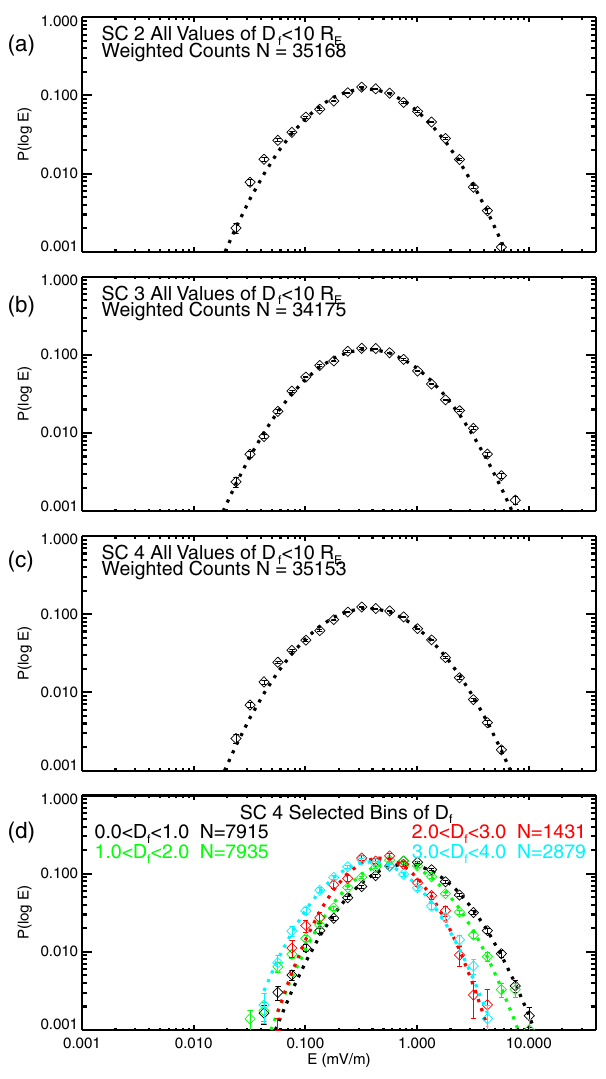
Fig. 4. Probability distributions for the electric field waveform am- plitudes observed by the Cluster WBD Plasma Wave Receiver on 26 March 2002. The probability distributions for all values of D f using weighted counts for (a) spacecraft 2, (b) spacecraft 3, and (c) spacecraft 4. The dashed lines show the fit to the Gaussian function predicted by stochastic growth theory. (d) Probability distributions from spacecraft 4 for selected 1 R E bins in D f